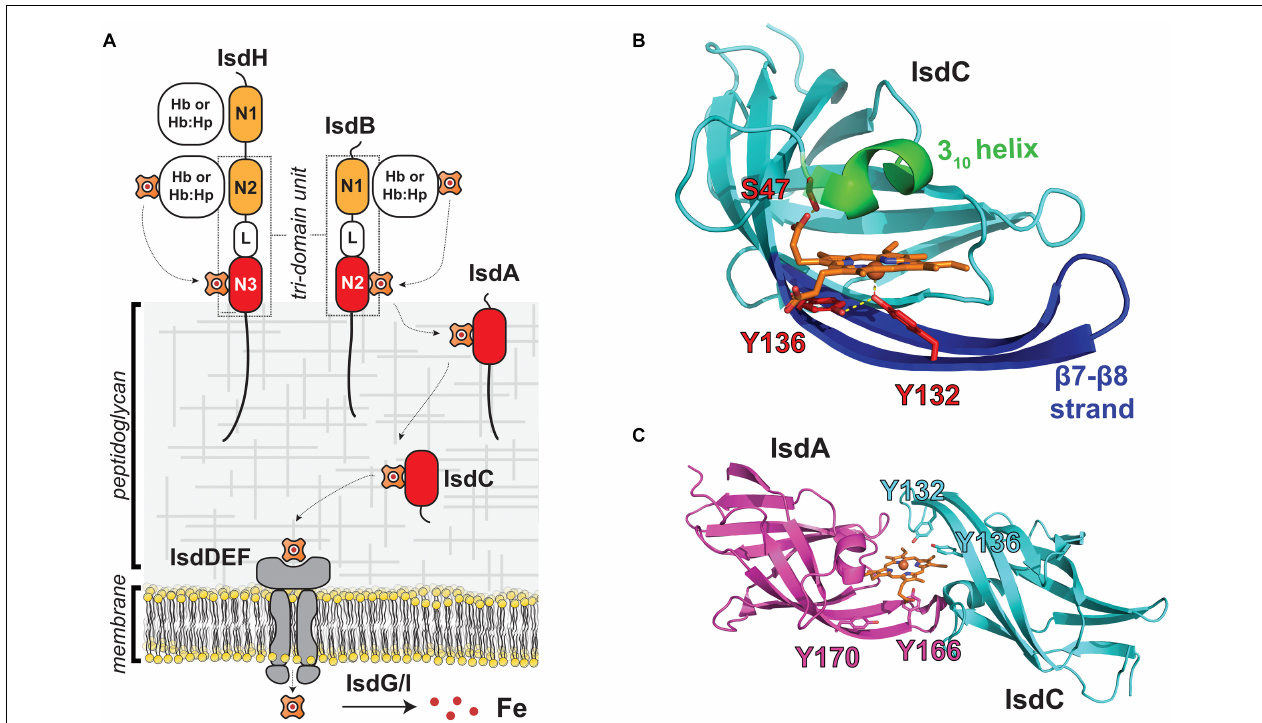
FIGURE 1 | NEAT domains act as heme chaperones on the surface of S. aureus . (A) Schematic of the S. aureus Isd heme acquisition system that uses NEAT domains to bind heme and Hb. The IsdB and IsdH proteins are Hb receptors and contain multiple NEAT domains that bind to either heme (red) or Hb (orange) and are bridged by a helical linker (L) domain. NEAT domains in the IsdA and IsdC proteins shuttle heme across the cell wall for import into the cell where it is degraded. Proteins containing NEAT domains are attached to the cell wall by SrtA (IsdA, IsdB, IsdC, and IsdH) or SrtB (IsdC) sortase enzymes. (B) Structure of the IsdC NEAT domain bound to pentacoordinate heme [PDB: 2O6P, (Sharp et al., 2007)]. Heme-binding residues in the S/YXXXY motif are labeled in red, the conserved 3 10 helix is indicated in green, and the β 7/ β 8 strands are shown in blue. Important hydrogen bonding and axial coordination interactions shown with yellow dashes (C) NEAT domains in IsdA [purple, PDB: 2ITF, (Grigg et al., 2007)] and IsdC [cyan, PDB: 2O6P, (Sharp et al., 2007)] transiently associate with one another to rapidly exchange heme. Model of the heme “handclasp” complex consistent with NMR, mass spectrometry and X-ray crystallography data. Other heme-binding NEAT domains also associate with one another to rapidly transfer. Their unique ability to rapidly exchange heme suggests that NEAT domains within the cell wall form a protein wire that transfers heme from the cell surface to the